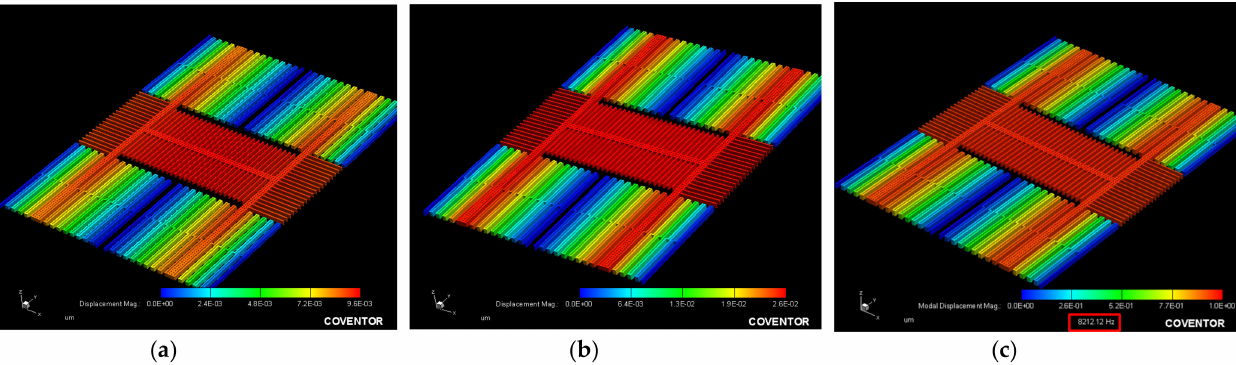
Figure 5. The magnetometer shows the plane motion direction along the ( a ) X -, ( b ) Y -, and ( c ) Z